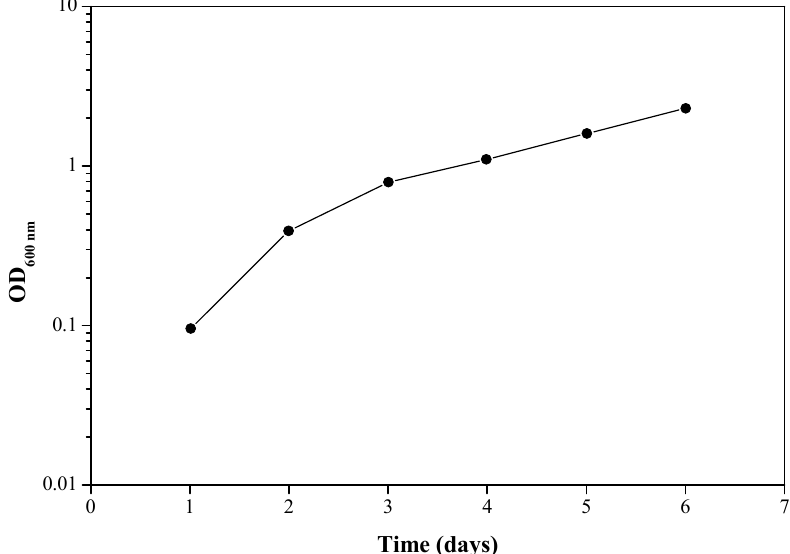
Figure 8. Growth of a mixture of Ochrobactrum anthropi and Rhodococcus rhodochrous on Davis epoxy LY 5052 growth medium. Each experiment was repeated at least five times; a typical result is shown here.